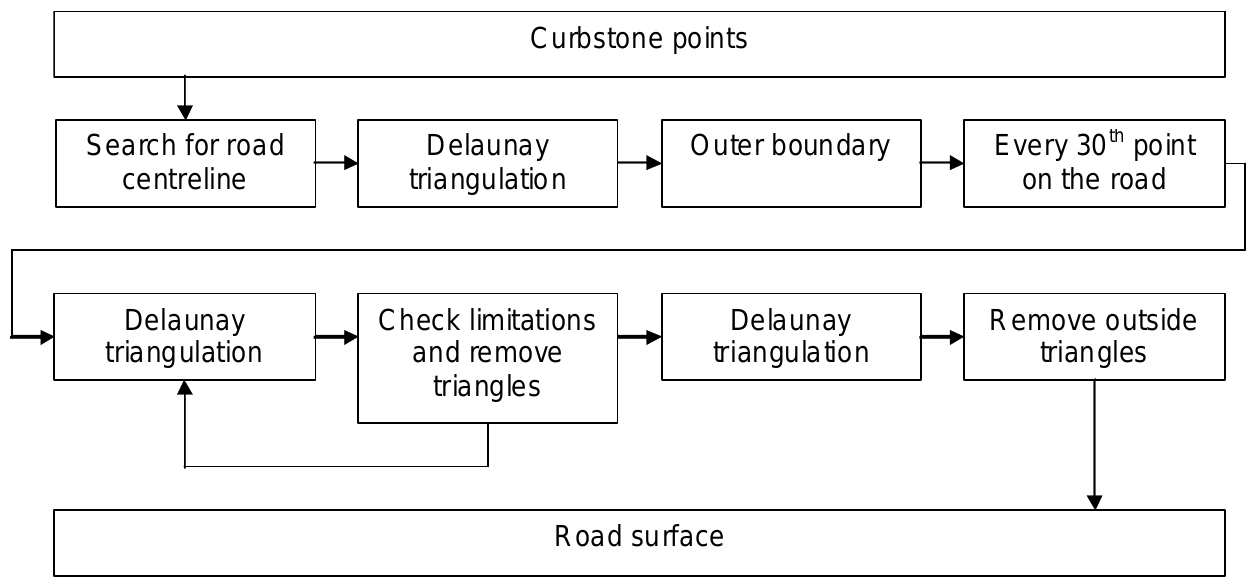
Figure 6. Road surface modelling